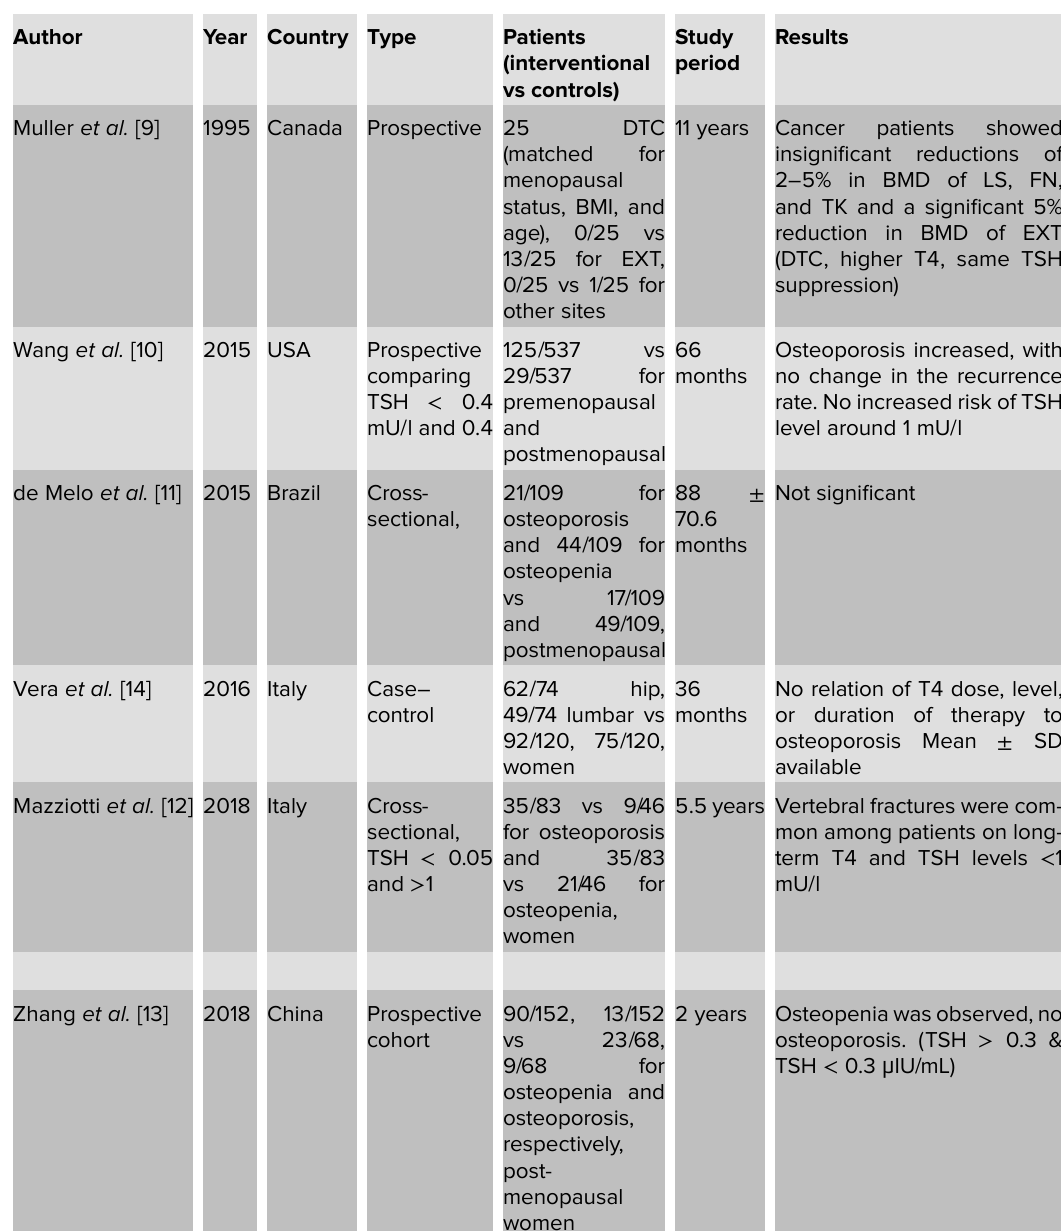
Table 2: The effect of long thyroid-stimulating hormone (TSH) suppressive therapy (following surgery for differentiated thyroid carcinoma) on bone mineral